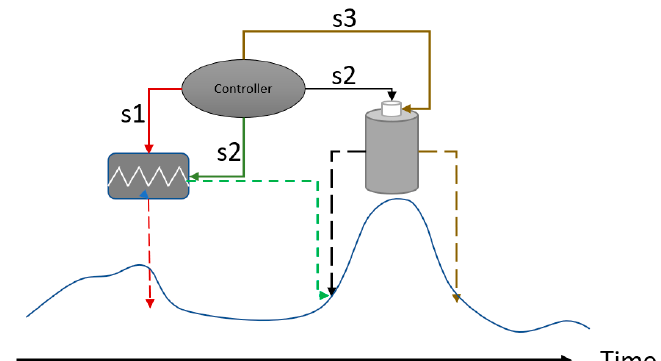
Figure 11. A control system that aligns demand response and battery usage. The blue line illustrates a load curve typically caused by a heater, before and after intervention. When signal s1 is activated, the load is suppressed by means of a regular demand response intervention. When s2 is activated the load suppression terminates. This causes a rebound effect; i.e., the heater works to reestablish set-point temperature. At the same time, the battery is discharged.